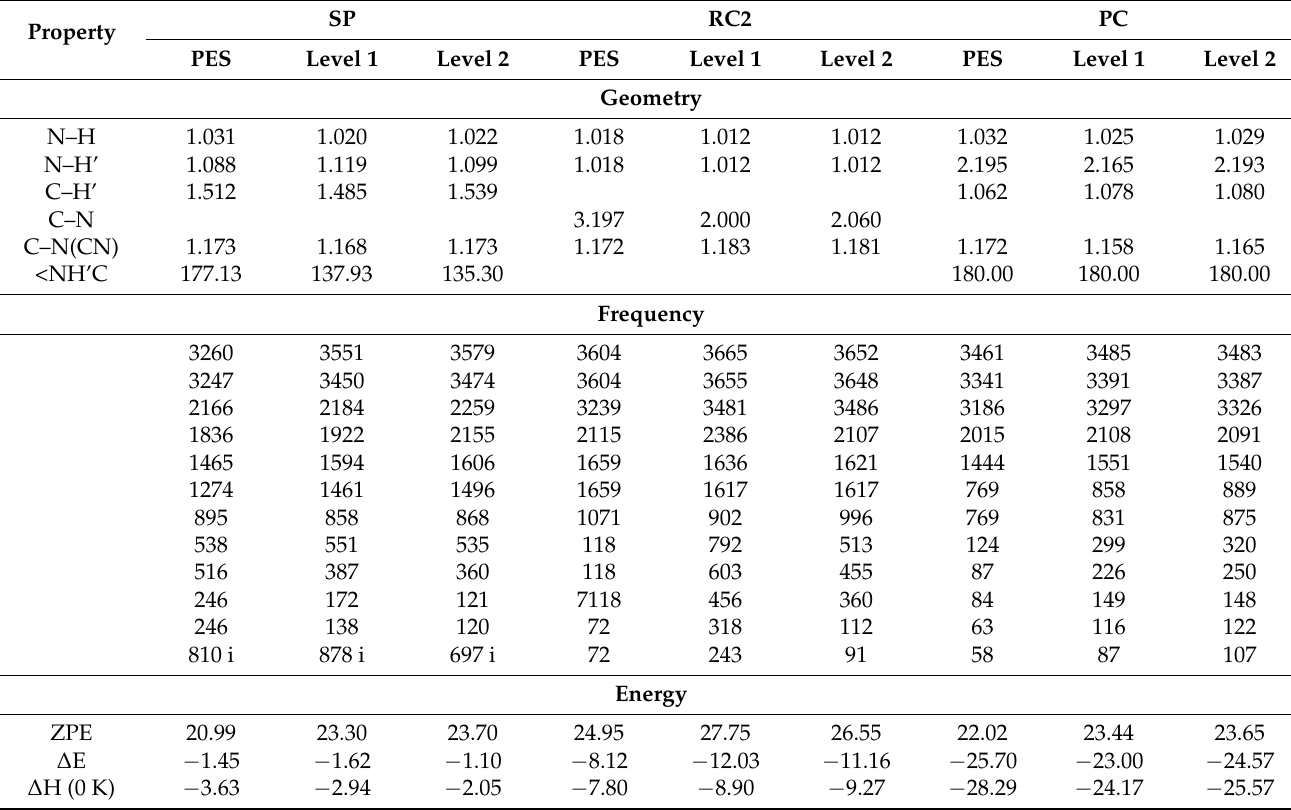
Table 2. Other stationary point properties (distances in Å, frequencies in cm − 1 , energy in kcal mol − 1 ) with PES-2020 and ab initio calculations a .